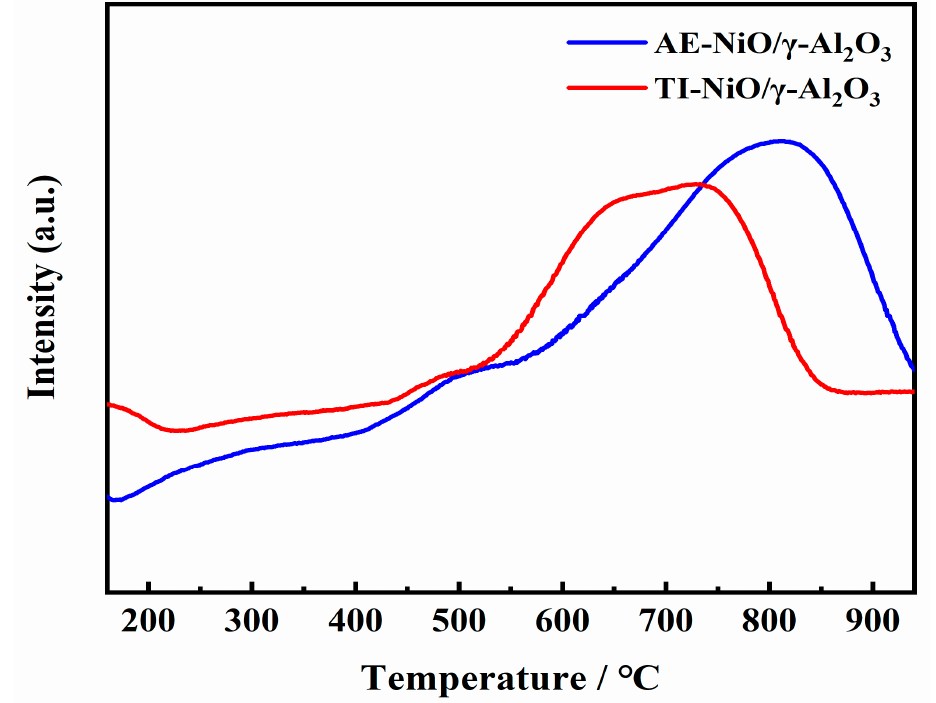
Figure 3. H 2 -TPR profiles of the calcined AE-NiO/ γ -Al 2 O 3 and AE-NiO/ γ -Al 2 O 3 samples.